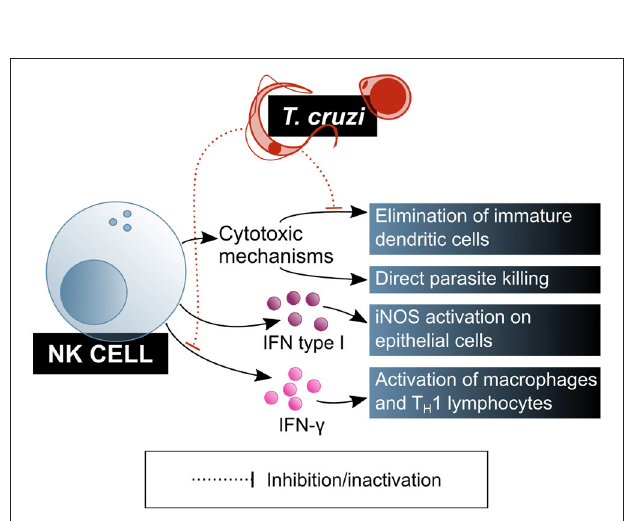
FIGURE 4 | T. cruzi is a target of NK lymphocytes, which are one of the main cells of the innate immunity contributing to parasite clearance. However, T. cruzi also has mechanisms that modulate NK lymphocytes function. Blue shaded boxes represent factors and mechanisms considered beneficial for the